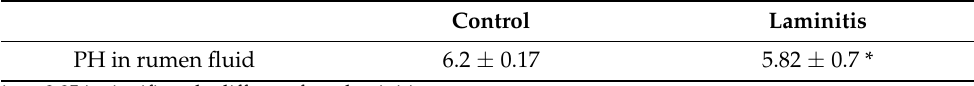
Table 3. PH in rumen fluid .